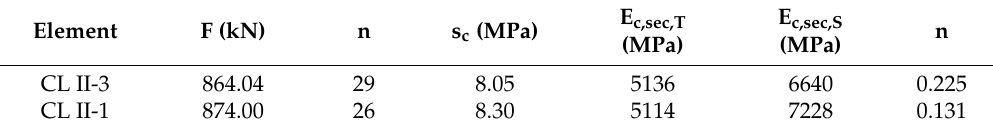
Table 6. Results from the compression tests.